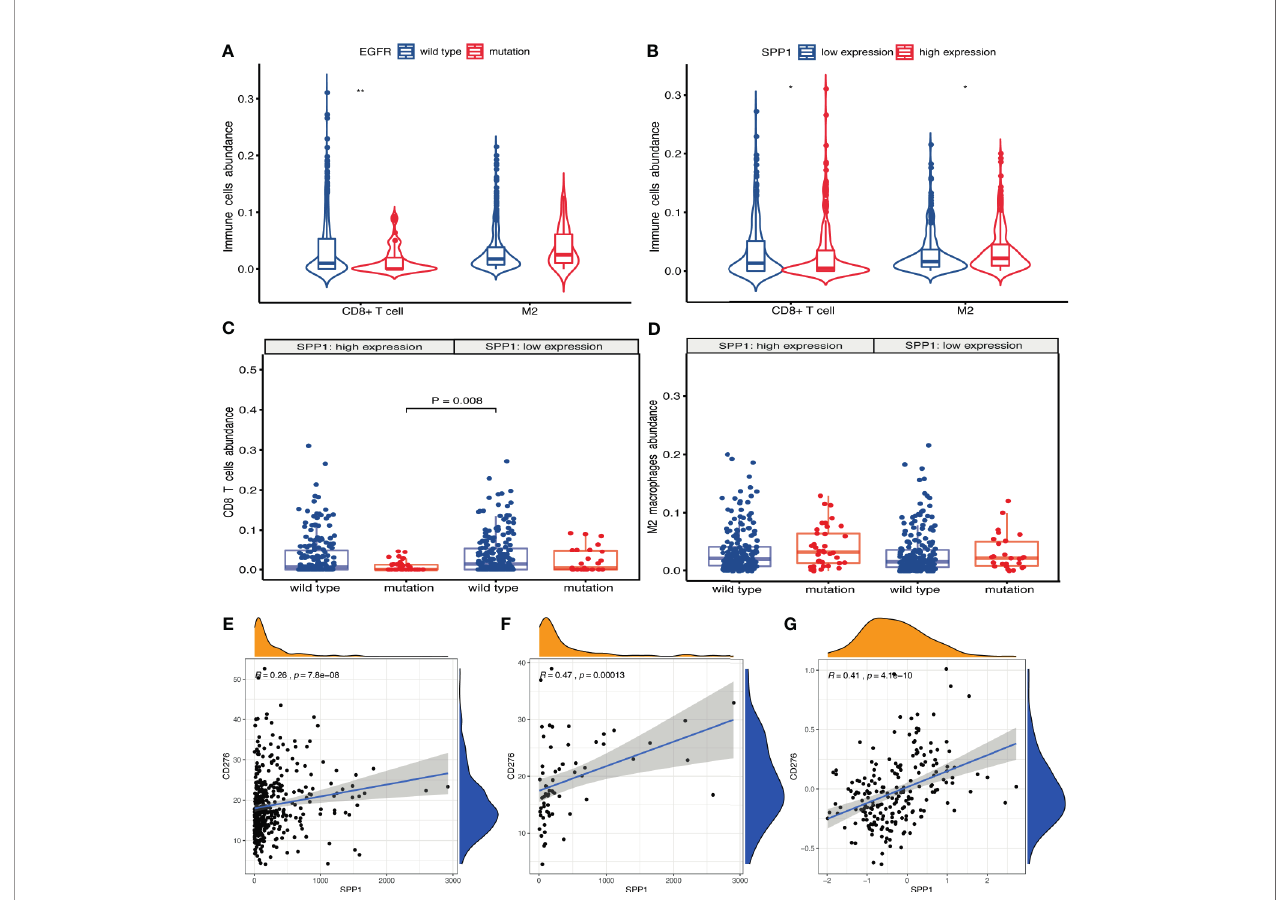
FIGURE 6 | SPP1 promotes immunosuppressive microenvironment in patients with EGFR mutation. (A) xCell calculated the abundance of CD8+ T cells and M2 macrophages in EGFR wild-type and mutant samples. (B) The abundance of CD8+ T cells and M2 macrophages in different SPP1 expression groups were evaluated by xCell. (C) Differences in CD8+ T cells abundance between EGFR mutation and wild-type patients with SPP1 high- or low-expression group. (D) Differences in M2 macrophages abundance between EGFR mutation and wild-type patients with SPP1 high- or low-expression group. (E) The expression of SPP1 was correlated with CD276 in EGFR wild-type patients at mRNA level. (F) The expression of SPP1 was correlated with CD276 in EGFR mutation patients at mRNA level. (G) The expression of SPP1 was correlated with CD276 at the protein level. *P < 0.05, **P <